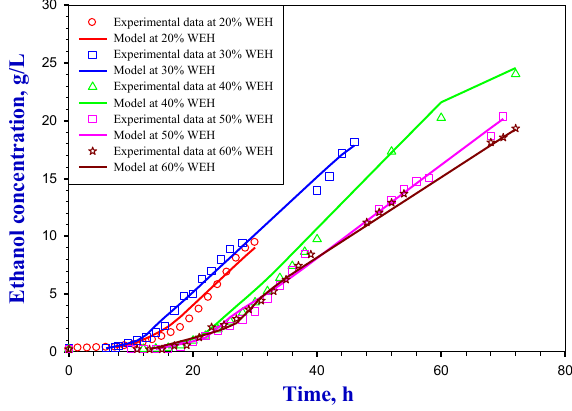
Figure 4. Experimental data and model results of ethanol production by recombinant E. coli FBWHR during fermentation from concentrated hot-water wood extract